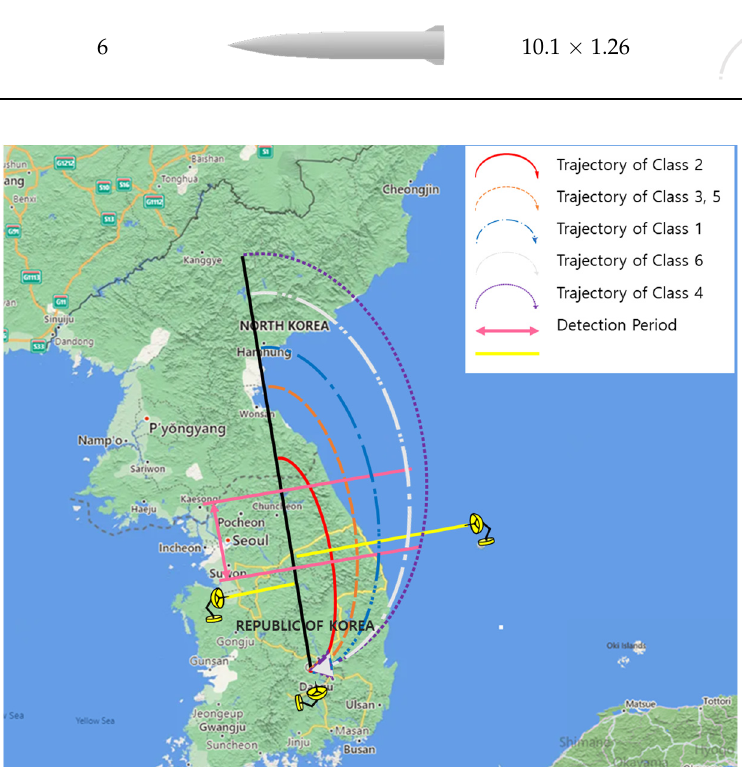
Figure 3. The detection